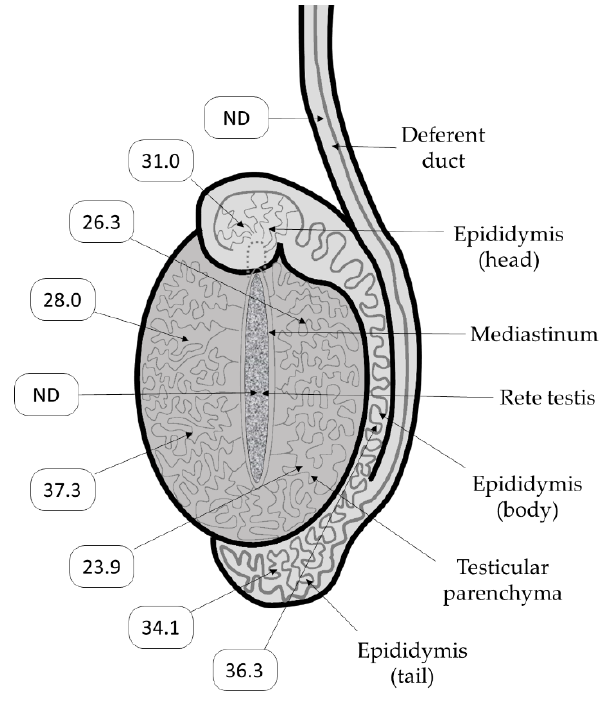
Figure 1. Schematic view of the affected testis of Bull 2. The numbers indicate the Ct values of swabs taken from the sites indicated by arrow heads. ND = BVDV RNA was not detected.